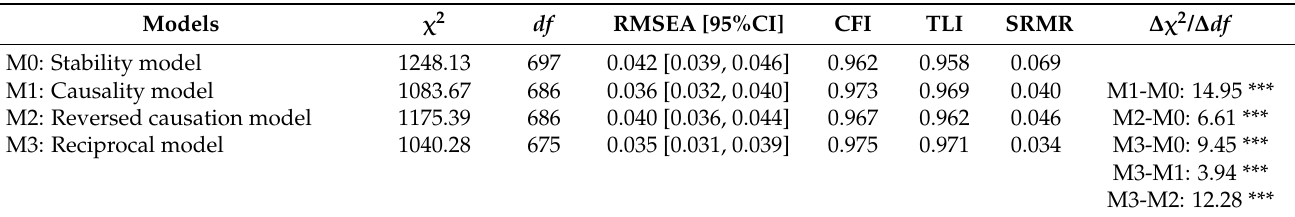
Table 2. Summary of model fit indices.